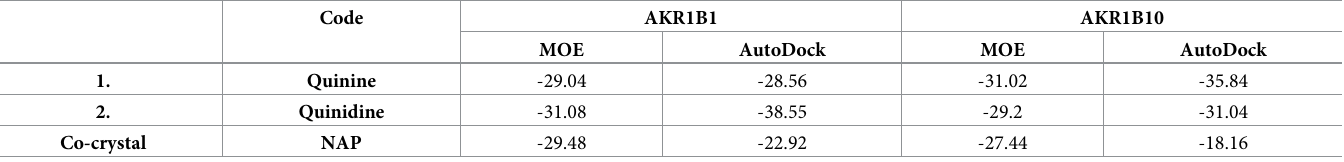
Table 3. Binding energies of quinolone derivatives with target AKR1B1 and AKR1B10